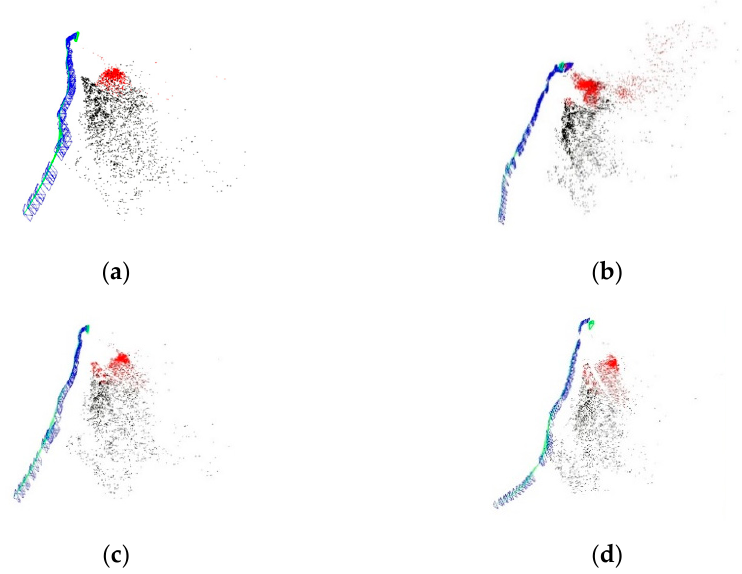
Figure 10. SLAM results for the Test 1 dataset. ( a ) Original; ( b ) CLAHE; ( c ) MF; ( d ) DCP.